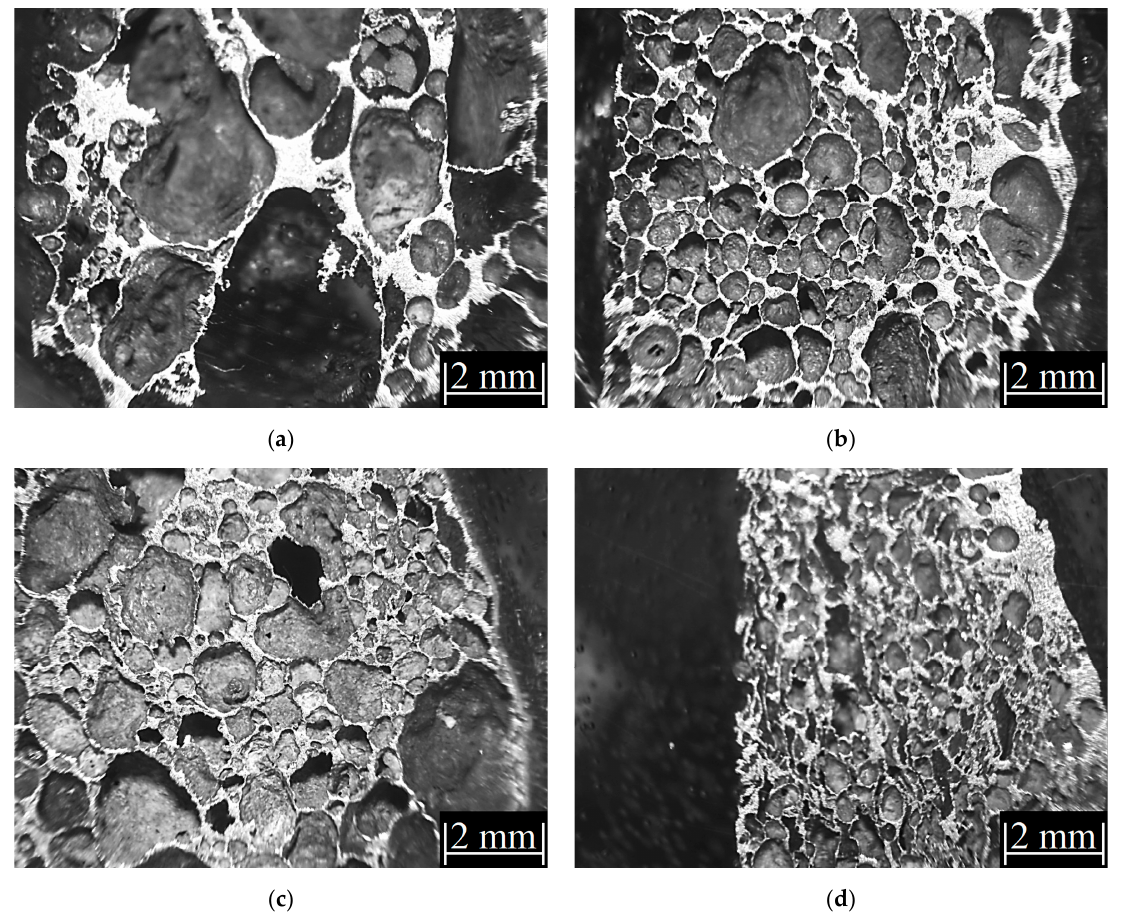
Figure 8. Representative optical microphotographs of the central region of the A356 aluminum alloy foams manufactured of ( a ) Foam 1, ( b ) Foam 2, ( c ) Foam 3, and ( d ) Foam 4.